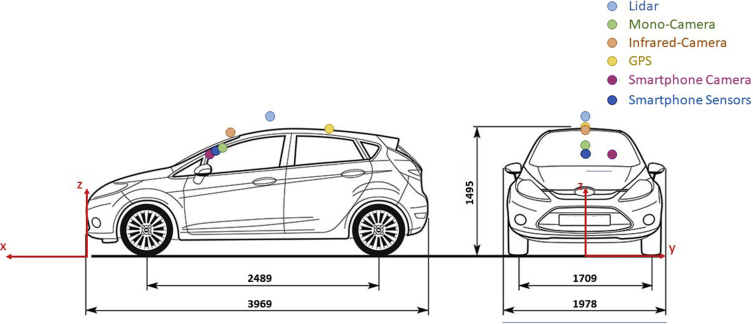
Vehicle dimensions and sensor positions [5].